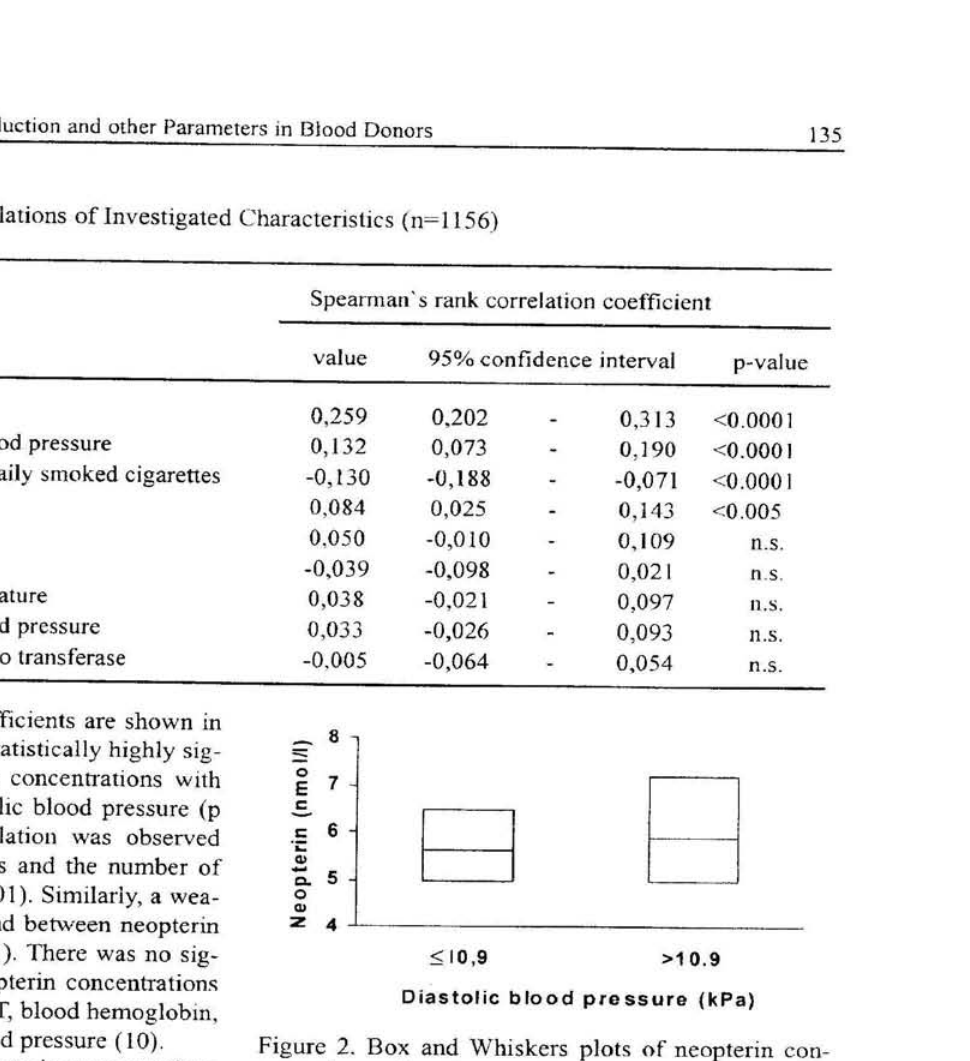
Figure 2. Box and Whiskers plots of neopterin con- centrations of patients with different diastolic blood pressure. The box extends from the 25"' percentile to the 75"' percentile, with a horizontal line at the median (50" 1 percentile). The median neopterin concentration of the group with diastolic blood pressure above